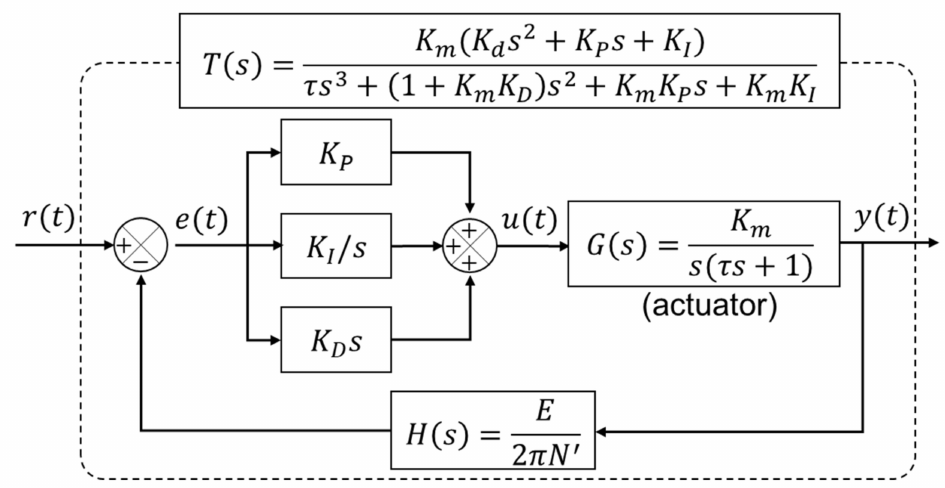
Figure 7. Block diagram of transfer function of the electric actuator